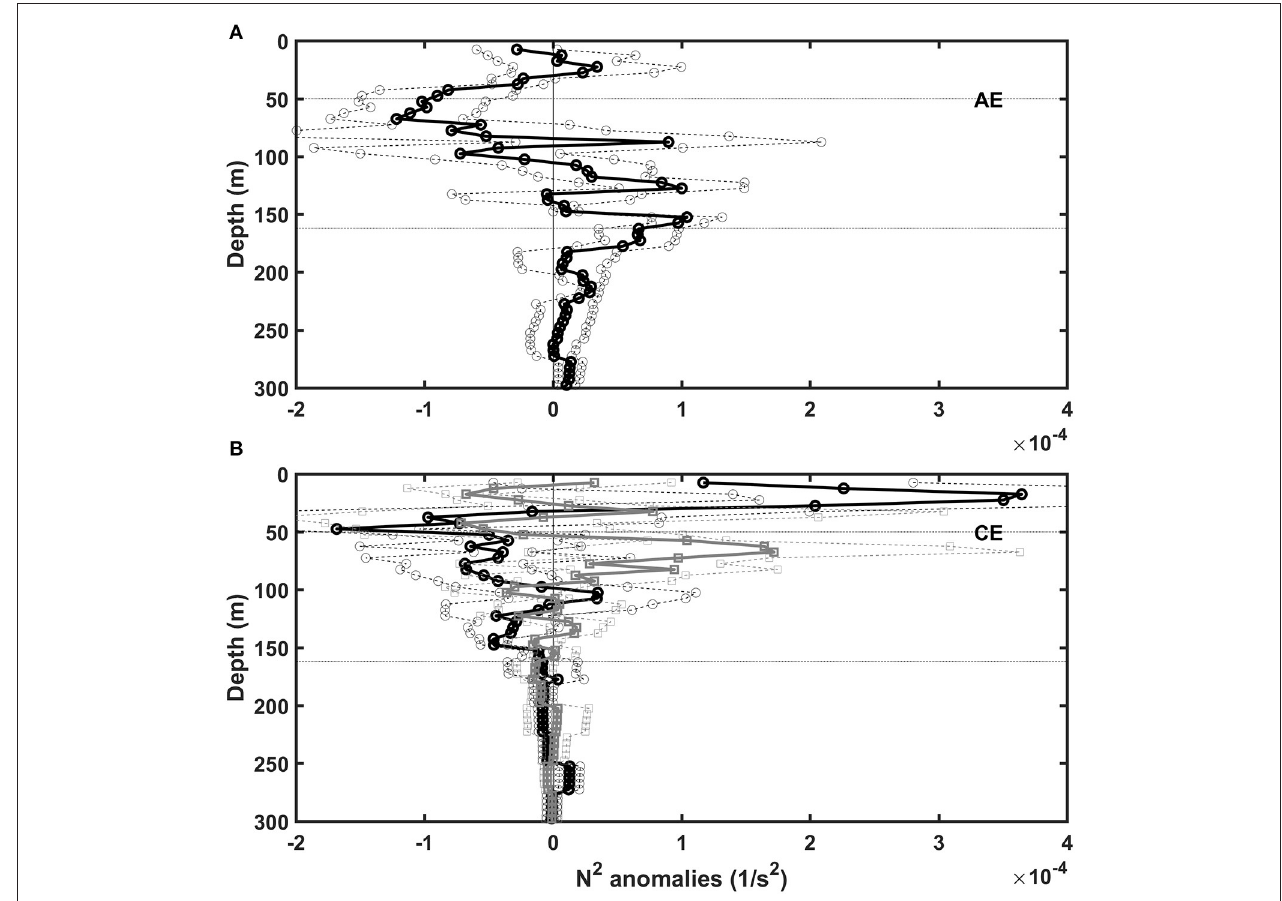
FIGURE 10 | Mean (solid curve) and standard deviation (dashed curves) of N 2 anomalies at the location of Argo floats observing (A) four anticyclonic eddies with significant downwelling and (B) three cyclonic eddies with (black curve) and without (gray curve) significant upwelling.